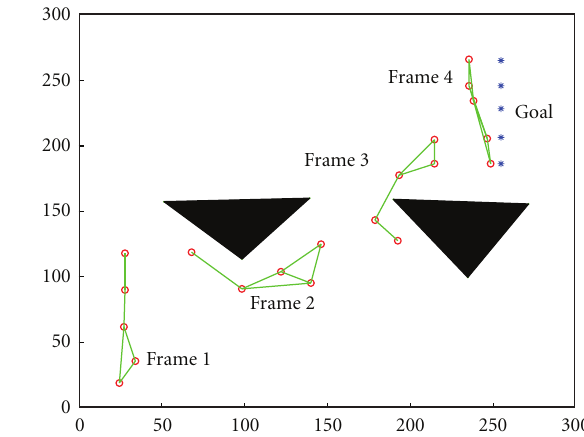
Algorithm 1: Algorithm for generating a feasible motion direction for Robot i , using time steps Δ t .